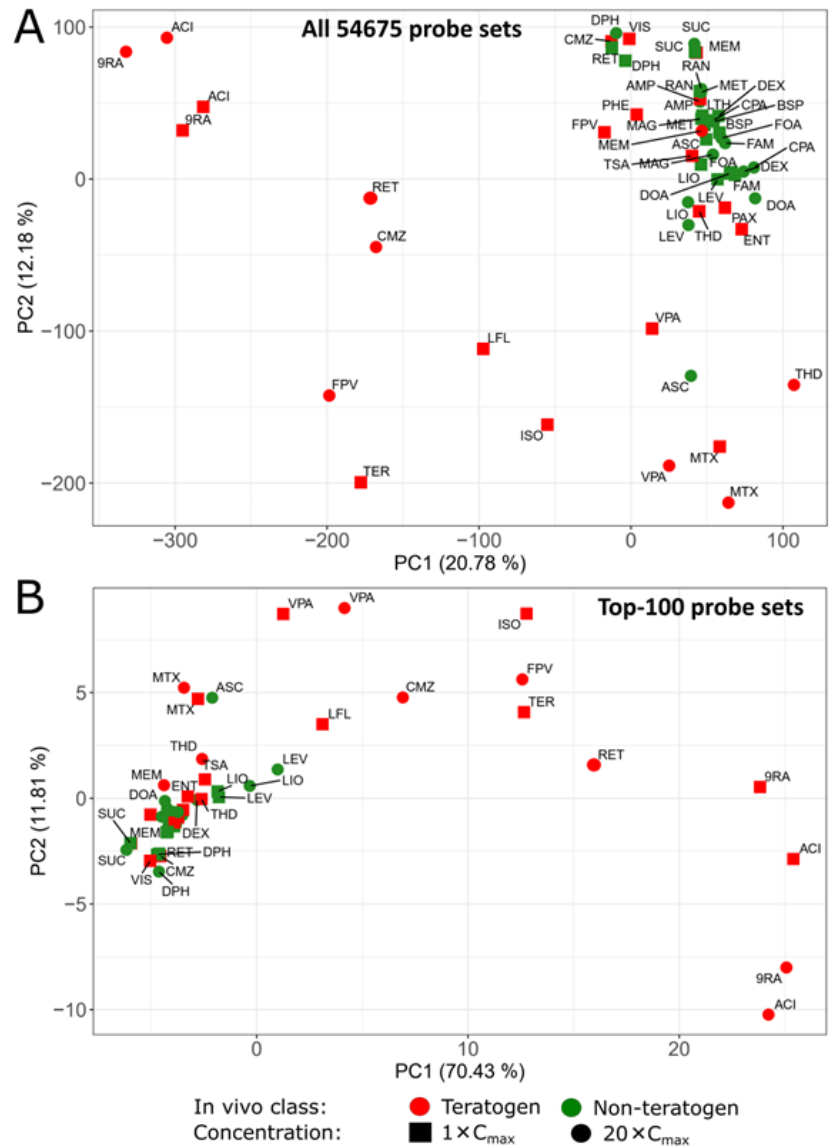
Figure 2. Principal component analysis (PCA) of the teratogenic and non-teratogenic compounds in the UKN1 test. Two PCA-Plots are presented of ( A ) all 54,675 probe sets and ( B ) the 100 probe sets with the highest variance across the mean of the condition-wise samples. Green and red tags represent in vivo non-teratogens and teratogens, respectively. 1-fold C max and 20-fold C max concentrations are indicated by squares and circles, respectively. The distribution of the data points on the x -axis is given by the principal component (PC) 1 and on the y -axis by PC2. The percentages in parentheses denote the proportion of explained variance for the respective PC. Compound abbreviations are explained in Table 1.